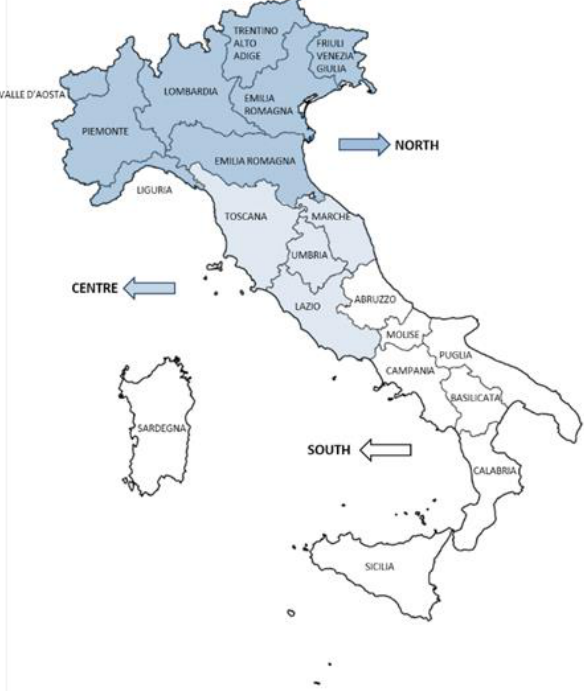
Figure 1. Regions of Italy and division between territories. Source: Own elaboration.